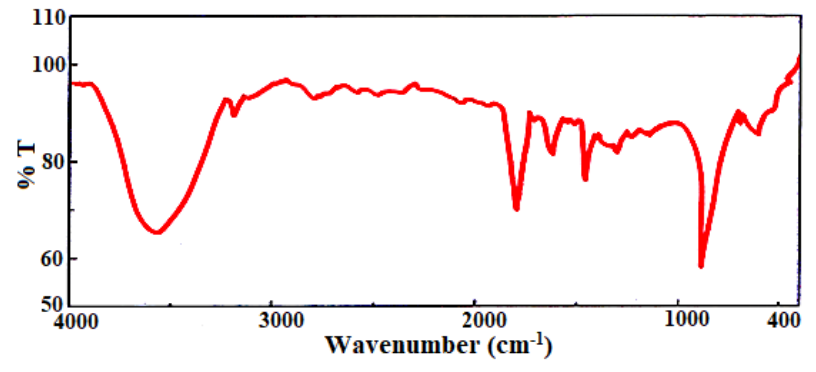
Figure 2. FT-IR spectrum of Pd NPs.